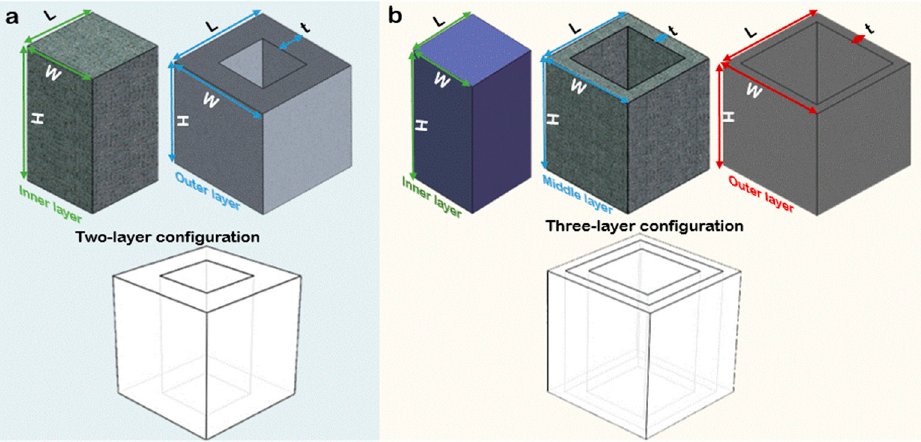
Figure A1. Configuration and parameters of ( a ) two-layer model and ( b ) three-layer model. Table A1. Dimensions of the multi-layer model.